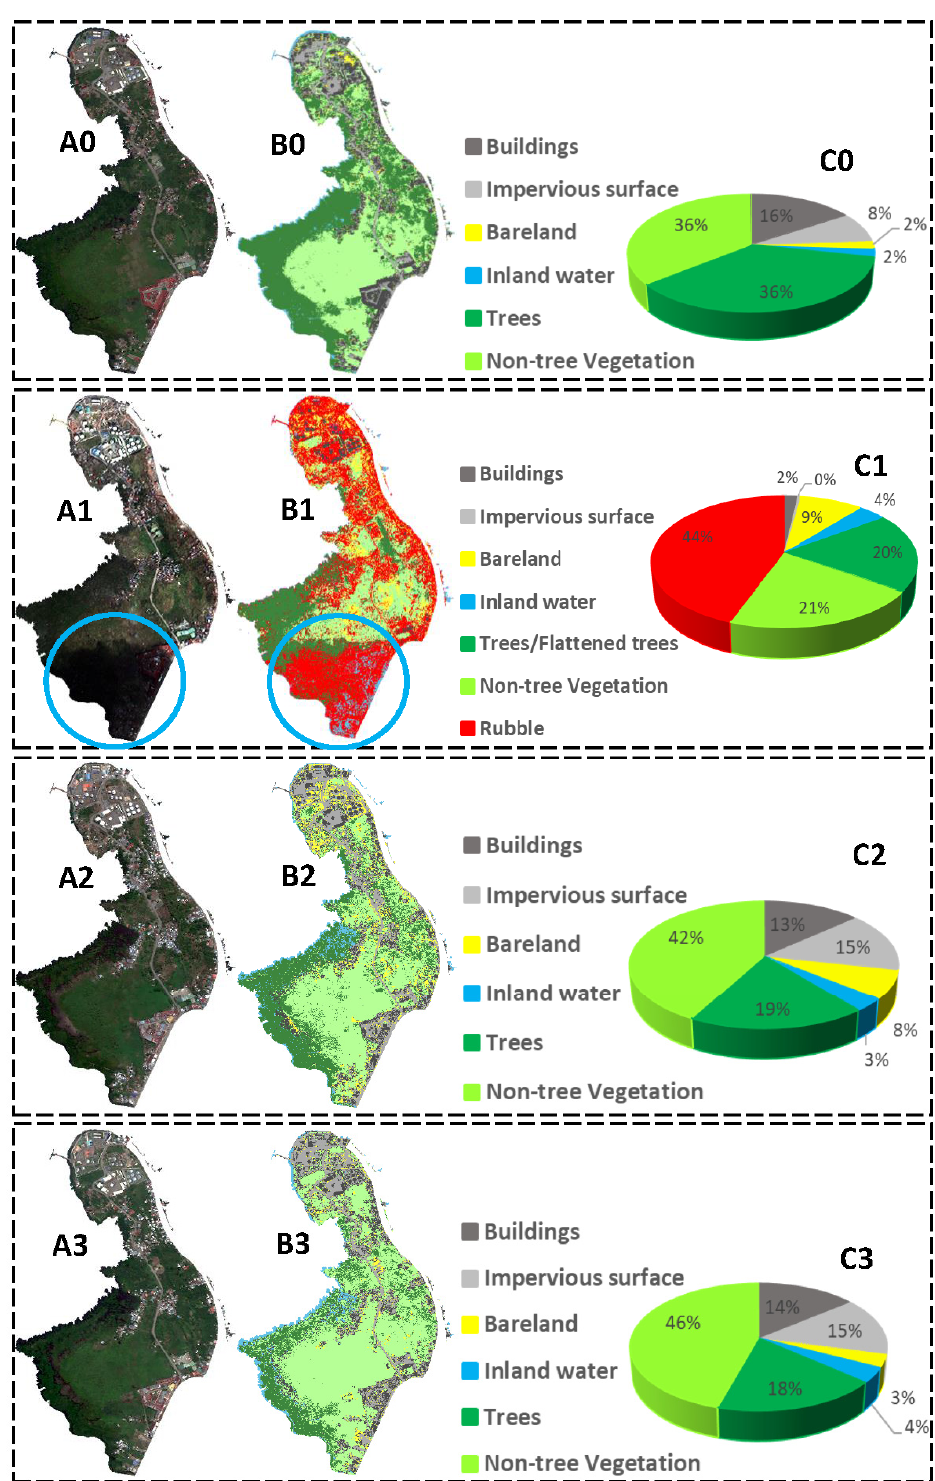
Figure 4. A0, A1, A2, and A3: Original very high resolution WorldView2, GeoEye1, GeoEye1, and WorldView2 satellite images, respectively, acquired over Barangay 69, Tacloban city from 8 months before (T0), right after (T1), 2 years (T3), and 3 years after Typhoon Haiyan (T3), respectively; B0, B1, B2, and B3: land cover (LC) classification result for the four time epochs; C0 , C1 , C2 , and C3 : corresponding pie charts show distribution of the LC classes. The area denoted by the blue circles in A1 and B1 shows shadowed area in the image.